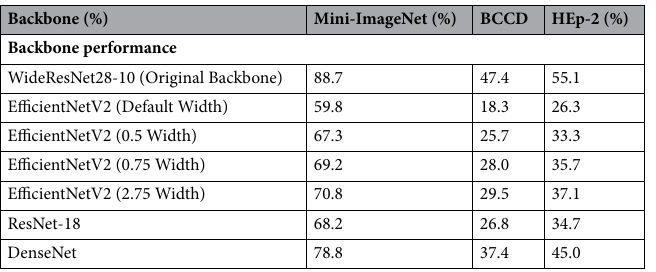
Table 5. Test accuracy results from using different backbone variations in EPNet on and testing on mini- ImageNet, BCCD, and HEp-2. Each backbone was trained on mini-ImageNet’s training set before